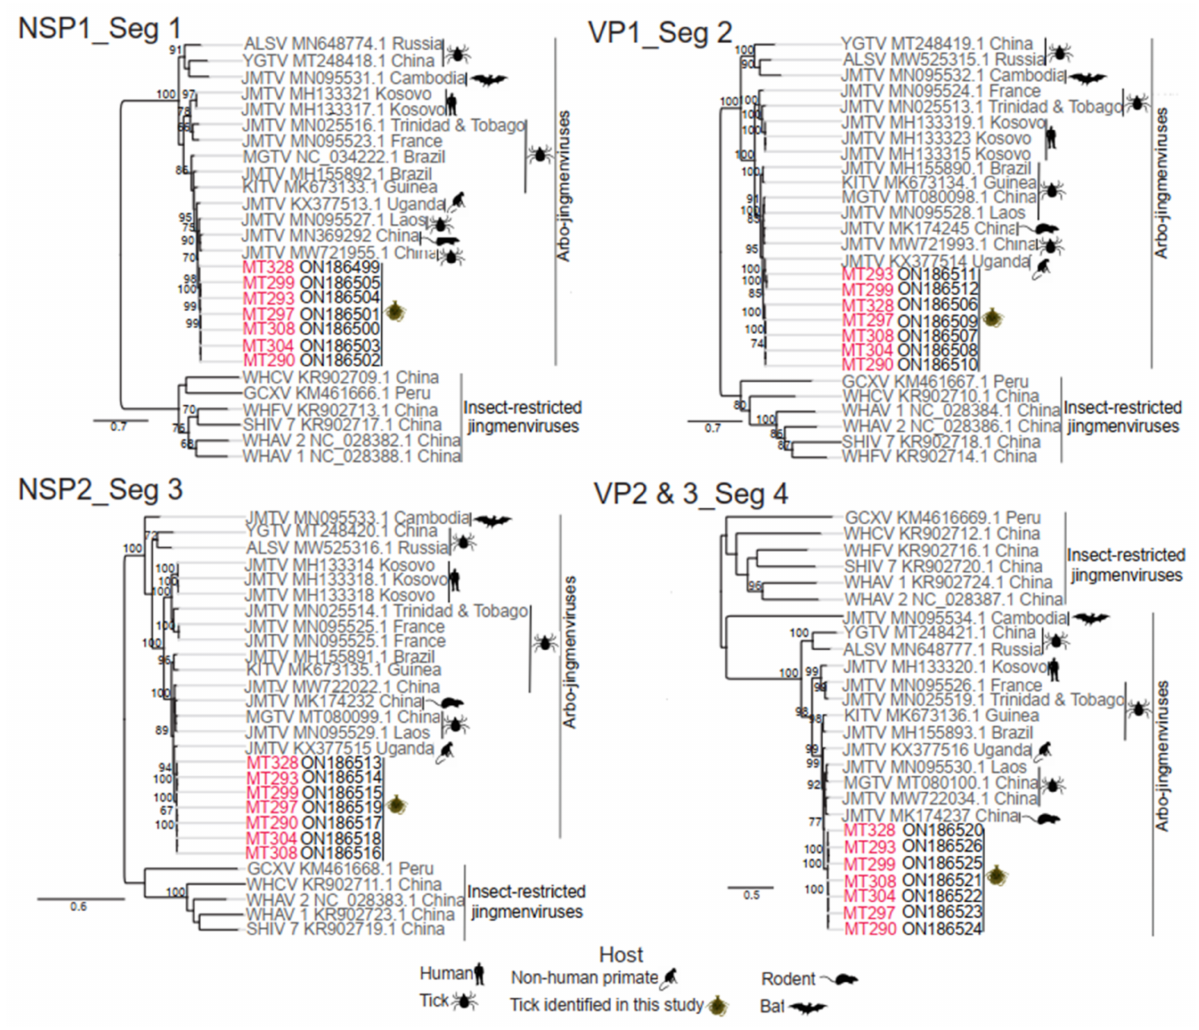
Figure 4. Phylogentic analyses of JMTV complete coding sequences. The maximum likelihood phylo- genetic analyses were based on nucleotide sequences of segements 1, 2, 3, and 4. Host information and geographic origin of the sequences are indicated. Phylogenetic trees were inferred from MAFFT alignment using PhyML v. 2.2.4 with General-time-reversible (GTR) substitution models employing 1000 bootstrap replicates. Trees are midpoint rooted. JMTV sequences identified in this study are highlighed in red. Bootstrap support values of more than 65 are